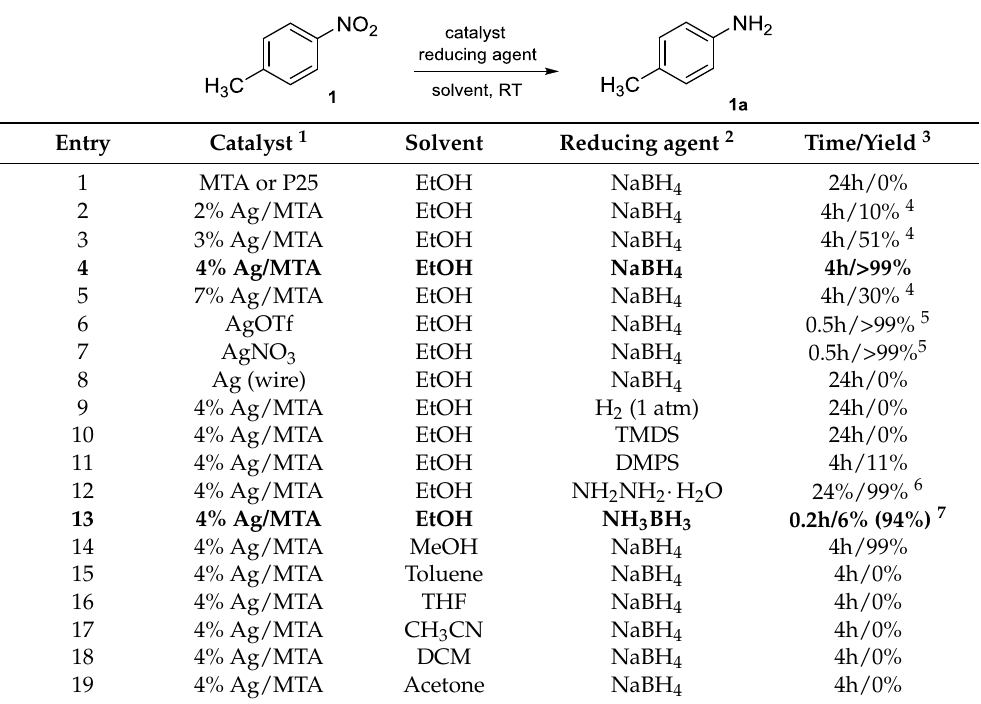
Nanomaterials 2016 , 6 , 54 Table 1. Evaluation of various Ag-containing catalysts, reducing agents and solvents in the catalytic reduction of 4-nitrotoluene ( 1 ) into 4-toluidine ( 1a ).